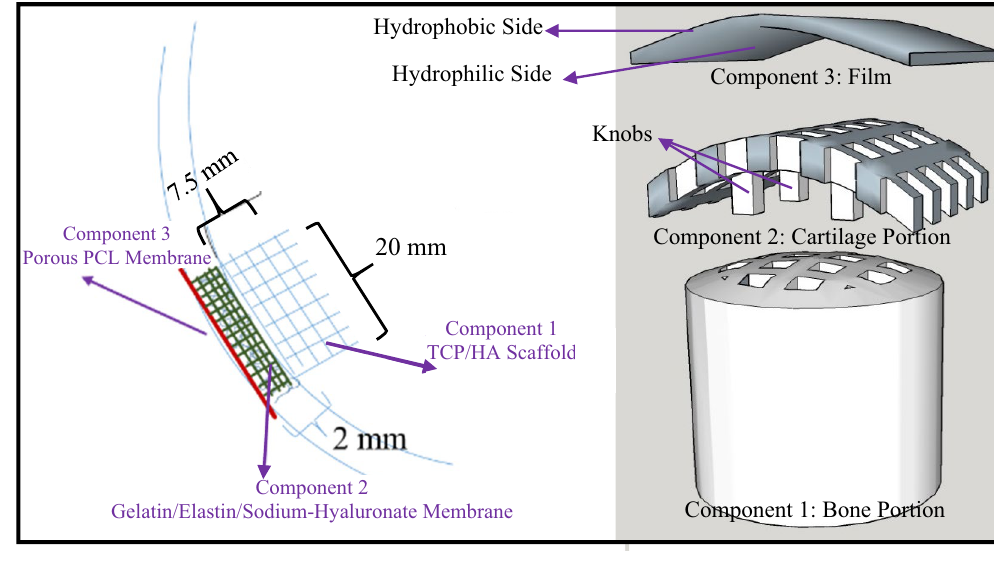
Figure 1. A schematic view of the tri-component knee